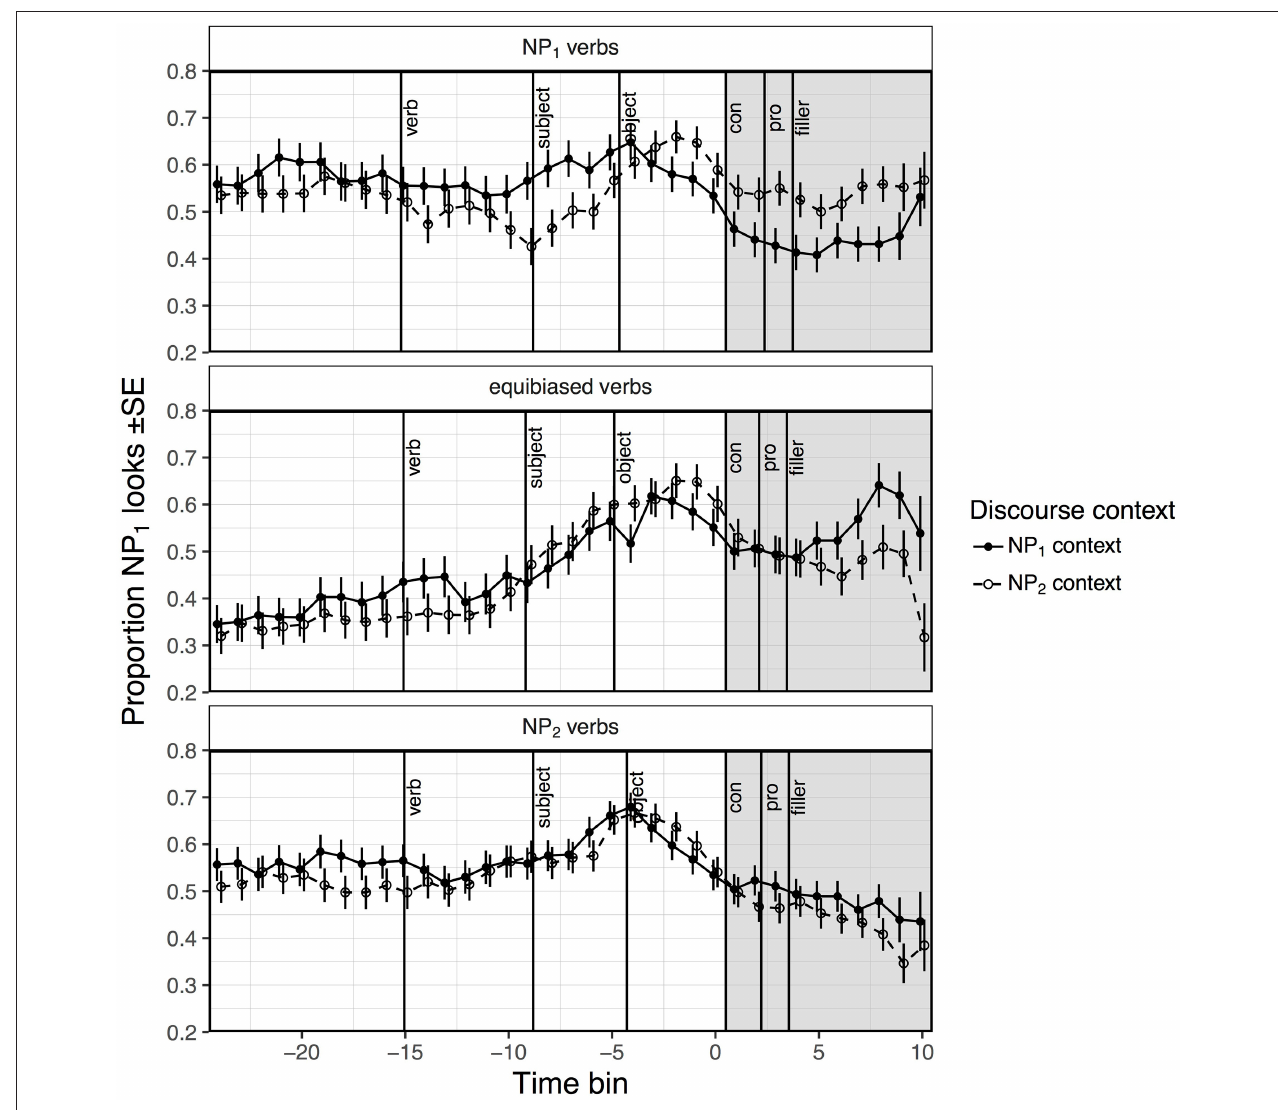
FIGURE 2 | The proportion of looks toward the NP 1 character out of looks toward the NP 1 and NP 2 characters per time bin in Experiment 1, by IC Bias and Discourse Context. The time window shows looks from 2500ms before the onset of the connective until the onset of disambiguating information. Each time bin represents 100ms. Vertical lines indicate the mean onset of the verb, subject, object, ambiguous pronoun (pro) and filler region per IC bias bin, and the onset of the connective (con), to which the data were time-locked. The shaded area indicates the region that was included in the statistical